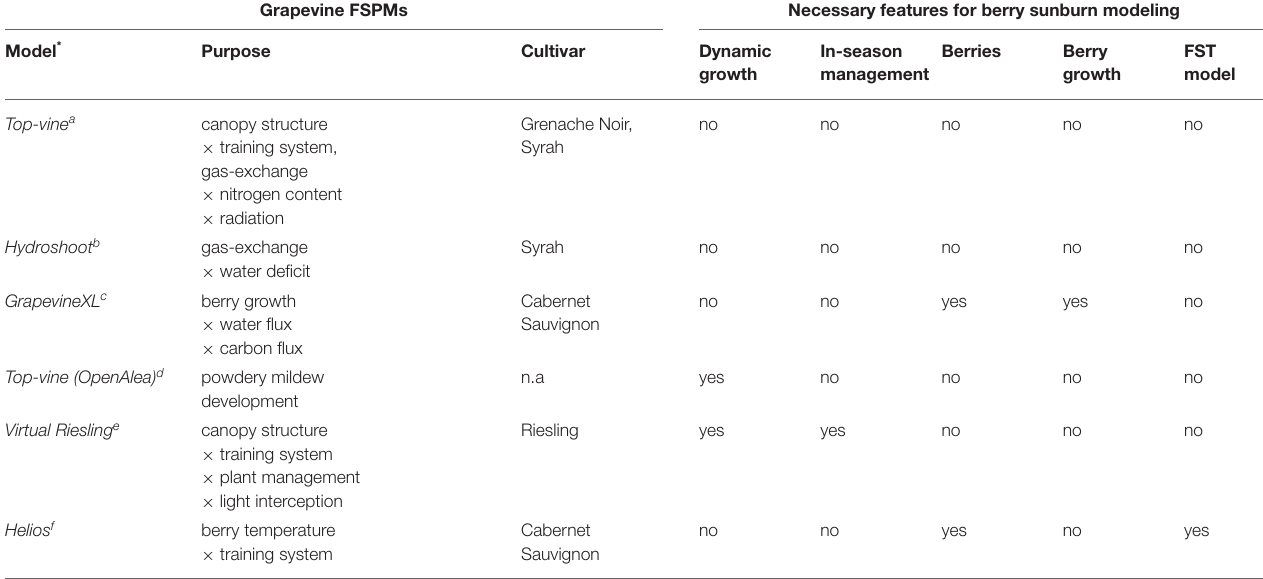
TABLE 1 | Grapevine FSPMs, their original purpose, and necessary features listed to model berry